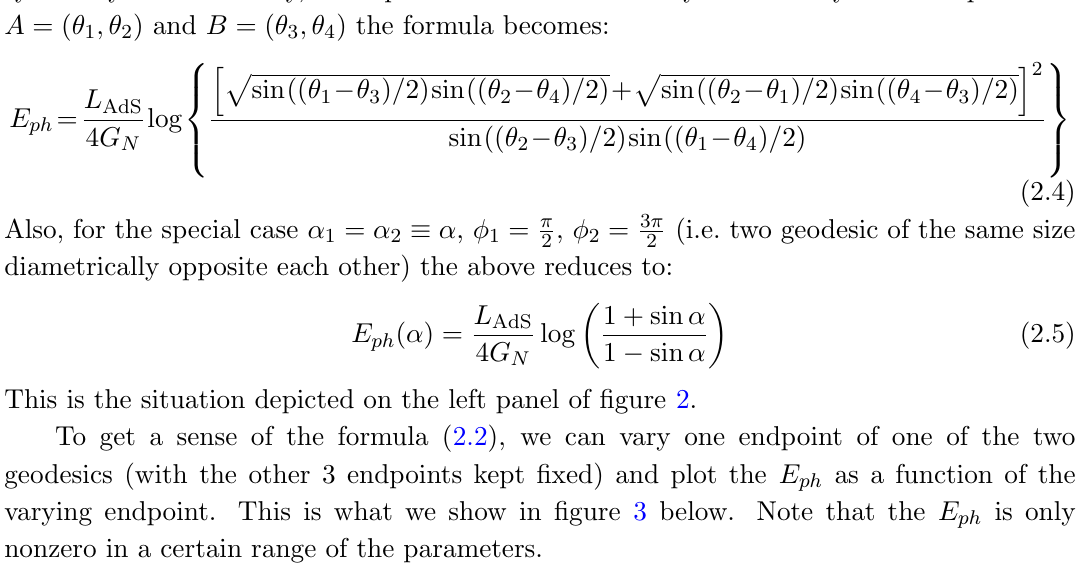
[0 ; b ]. The 2 1 : 256 (where the RT surface (cid:25)